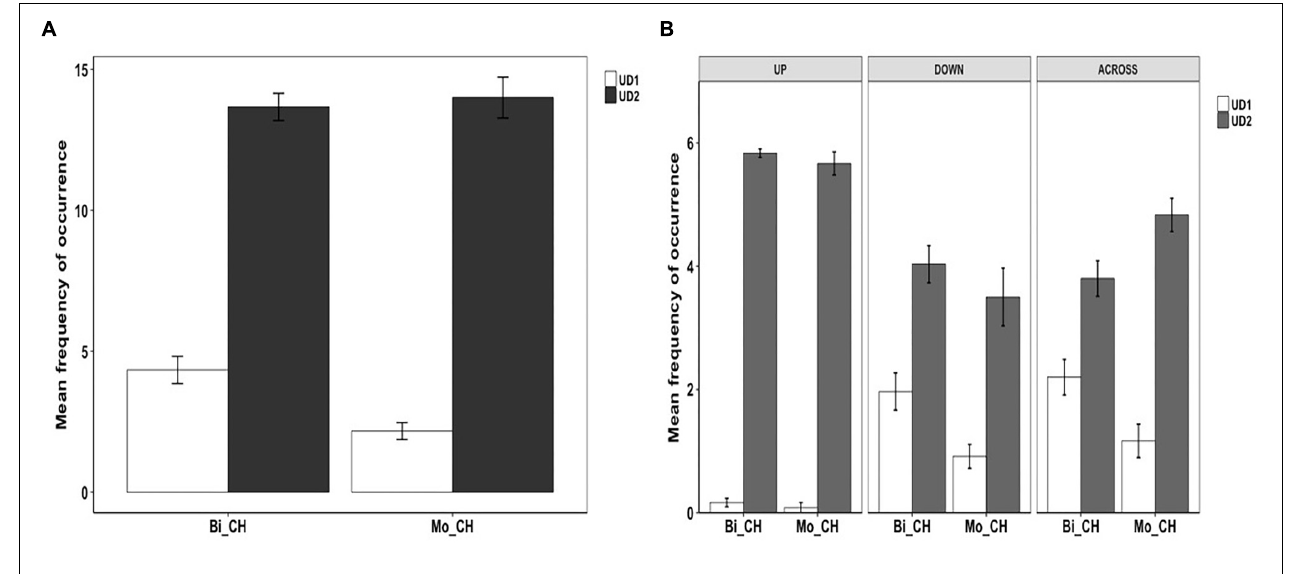
FIGURE 6 | Utterance density in